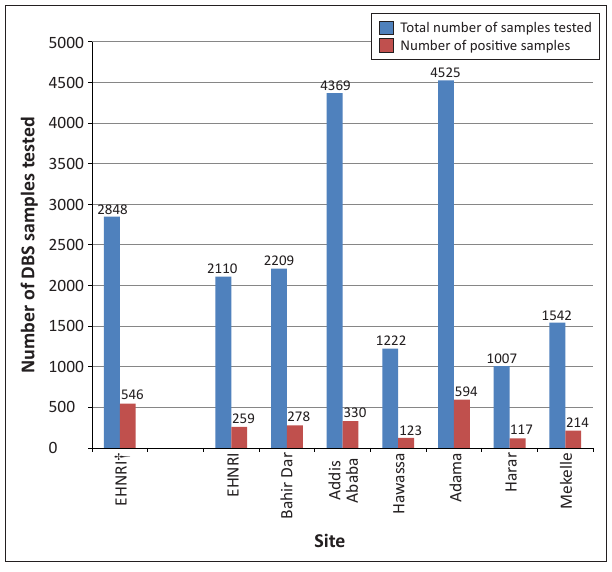
Impact of expansion of DNA polymerase chain reaction (PCR) laboratory for early infant diagnosis of HIV-1. Dagger ( † ) denotes the only site the Ethiopian Health and Nutrition Research Institute (EHNRI) before rollout to new sites in the regions. The total number of DBS specimens tested and the number positive for each site is shown at the top of each bar FIGURE 3: Proportion of dried blood spot (DBS) tested positive by